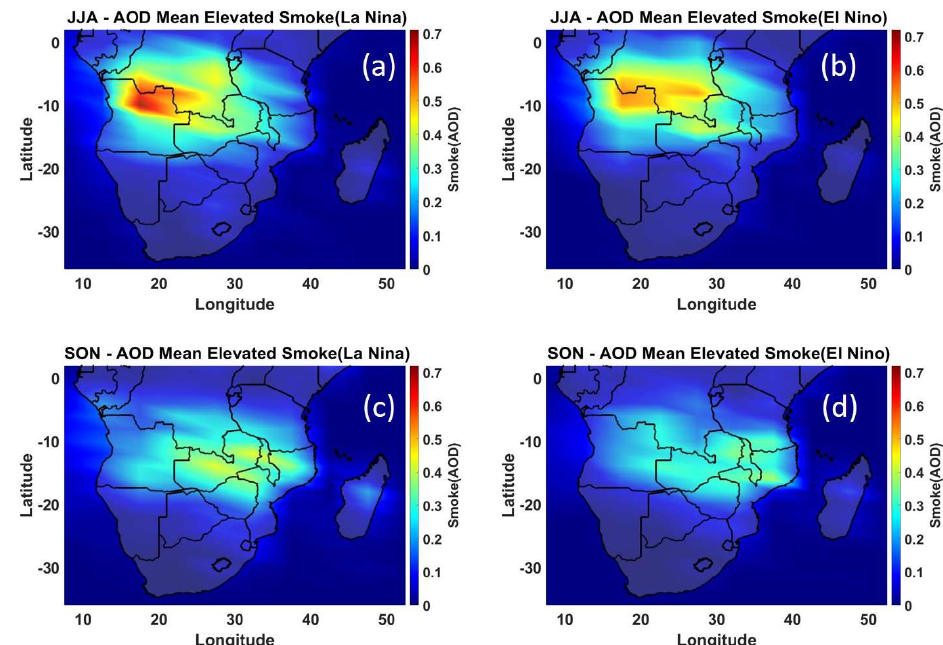
Figure 8. Spatial distribution of AOD mean elevated smoke for the JJA ( a , b ) and SON ( c , d ) periods during the La Niña ( a , c ) and El Niño ( b , d ) events.